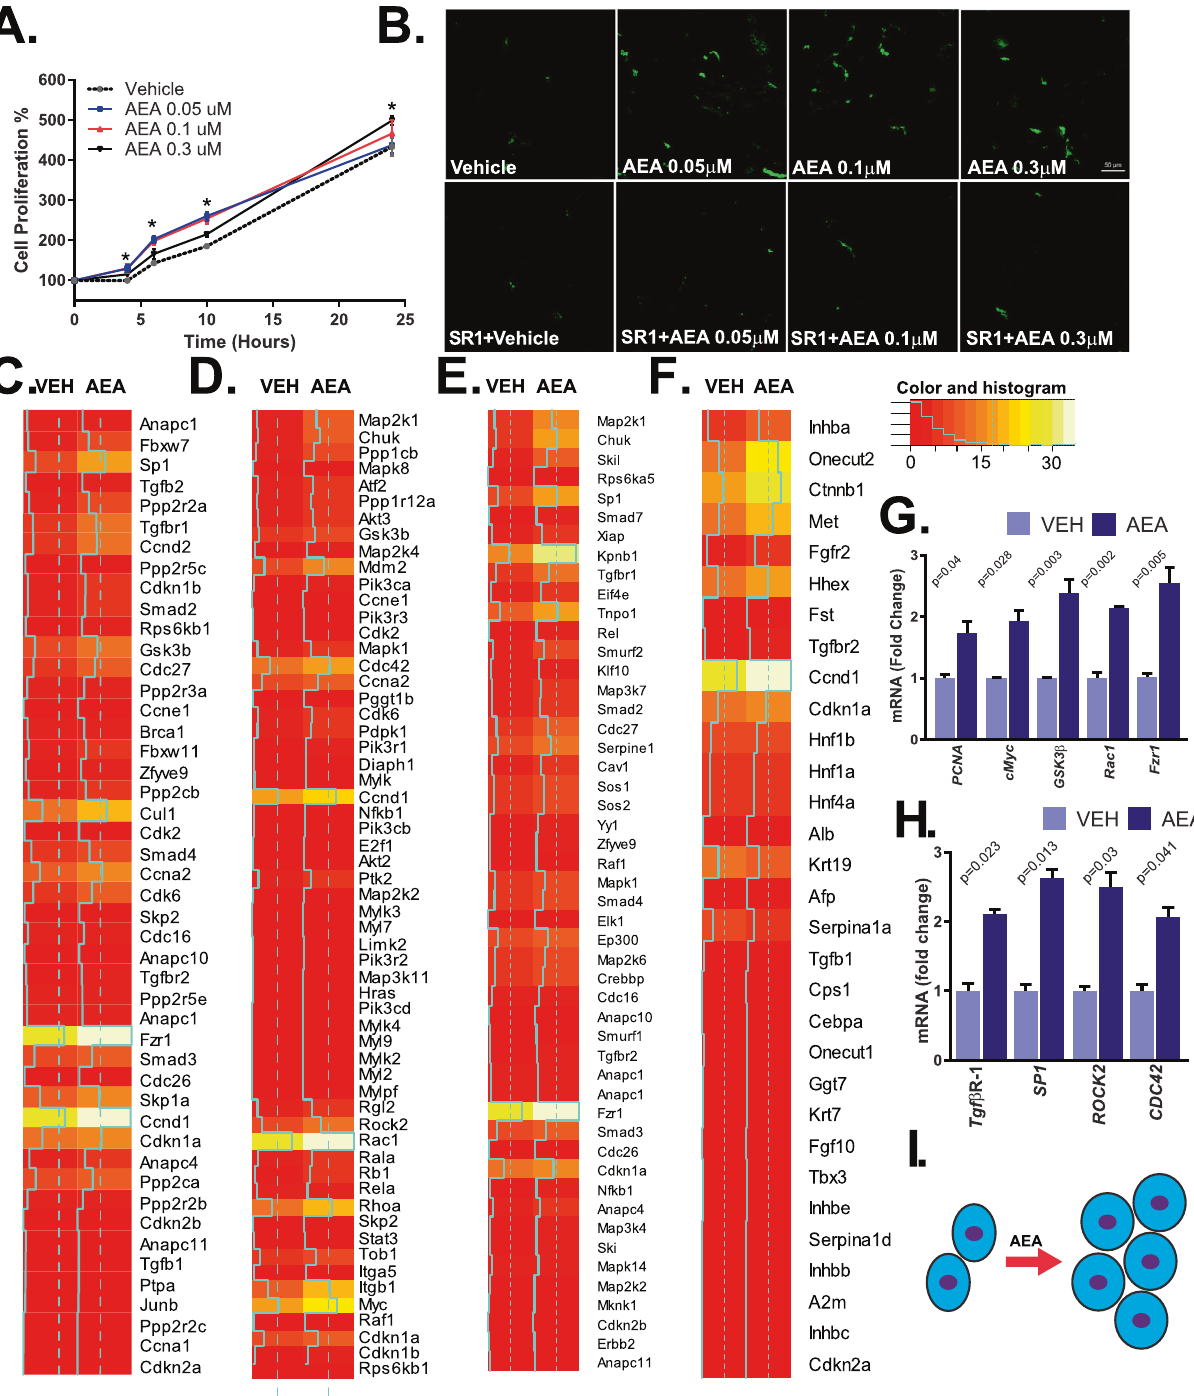
Fig. 2 Effect of AEA on the proliferation and transcriptome analyses reveal distinct modulation of cell cycle and cell differentiation pathways by AEA in mouse HPCs. A A concentration-dependent increase in proliferation of cells exposed to 50 – 300 nM anandamide. B Inhibition of the pro-proliferative effect of AEA by the CB 1 R antagonist SR1 (rimonabant), as monitored by BrdU incorporation and detected by fl uorescence confocal microscopy in BMOL. C – F RNA-seq analyses of six pooled samples of BMOL cells treated with vehicle (VEH) or AEA (300 nM) are presented as heat maps. These heatmap data reveal AEA-induced genes involved in cell cycle regulation, including regulation of G1/S transition ( C ) and Ras and Rho proteins ( D ); and cellular differentiation, including TGFß-receptor signaling ( E ) and transcription factors involved in hepatocyte lineage segregation ( F ). Differentially expressed genes are highlighted by color coding and by a solid blue line in the heatmap. G Real-time PCR validation of fi ve highly regulated target genes in cell cycle pathways (PCNA, cMyc, GSK3 β , Rac1, and Fzr1) from three additional samples ( n = 3/group, * P < 0.05 AEA-treated vs vehicle-treated cells). H Real-time PCR validation of four target genes in cell differentiation pathways (TGF β R-1, SP1, ROCK2, and CDC42) were veri fi ed by real-time PCR analyses ( n = 3/groups, * P < 0.05 AEA-treated vs vehicle-treated cells). I Schematic summary model of the effect of AEA in